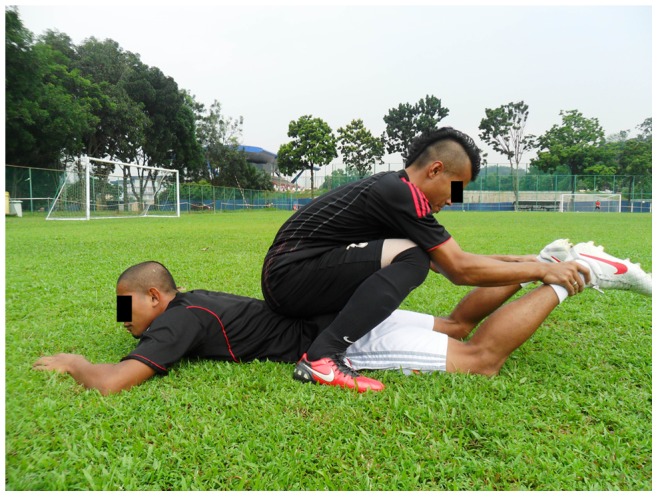
Hamstring curl (in pairs).